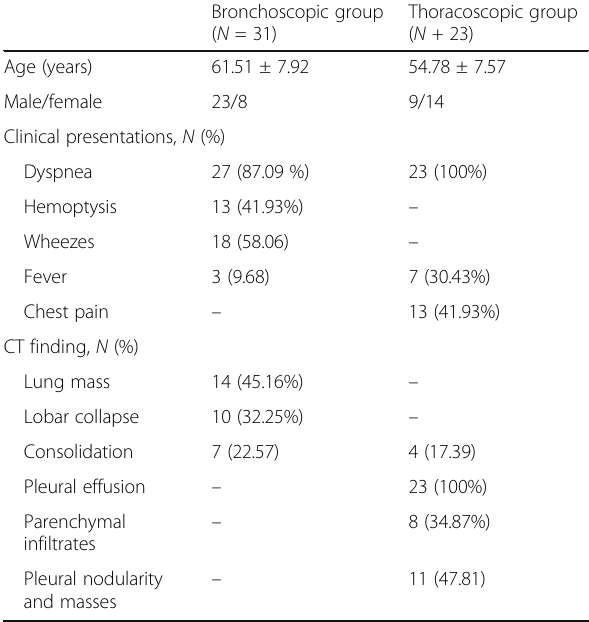
Table 1 Demographic, clinical, and radiological characteristics of the studied patients